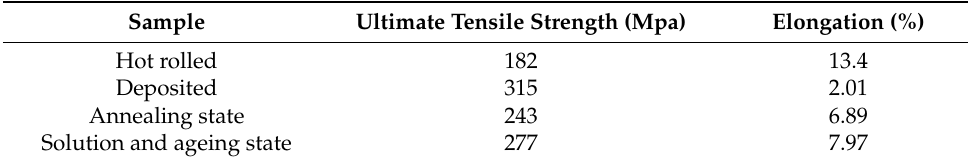
Figure 10. Engineering stress–strain curves for the samples. Table 3. Mechanical properties of the